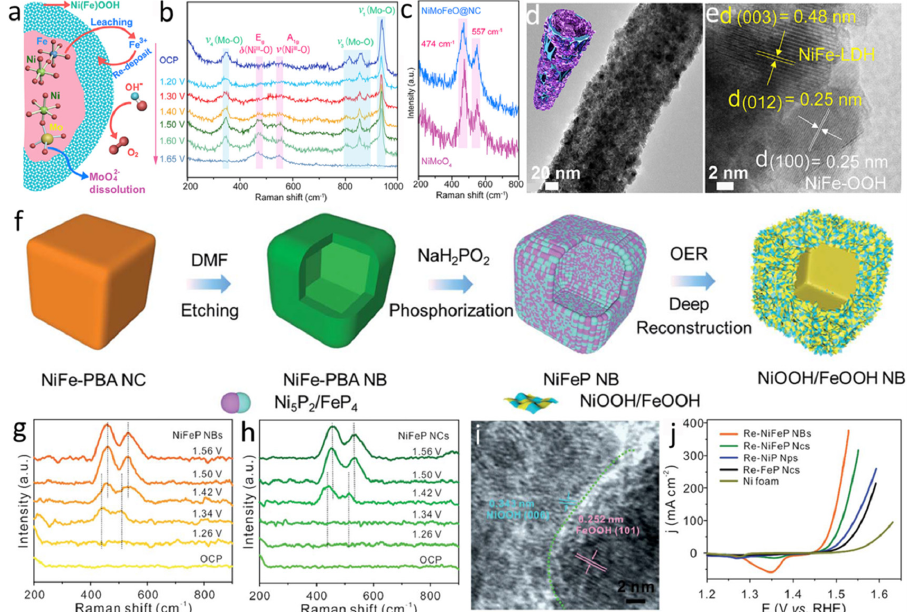
Figure 7. ( a ) Schematic of the reconstruction process for NiMoFeO@NC. ( b ) Operando Raman spectra of NiMoFeO@NC. ( c ) Operando Raman spectra of NiMoFeO@NC and NiMoO 4 obtained at 1.65 V. ( d ) Low-magnification and ( e ) high-magnification TEM images of NiMoFeO@NC after electrochemical reaction. Reproduced with permission [119]. Copyright 2020, Cell Press. ( f ) Schematic for the formation of precatalysts and deep reconstruction process of precatalysts into hierarchical NiOOH/FeOOH structures. Operando Raman spectra of ( g ) NiFeP NBs and ( h ) NiFeP NCs at different applied potentials. ( i ) HRTEM image of NiOOH/FeOOH structures. ( j ) LSV curves of catalysts loaded on Ni foam after 30 h of reconstruction process. Reproduced with permission [118]. Copyright 2021, Royal Society of Chemistry.